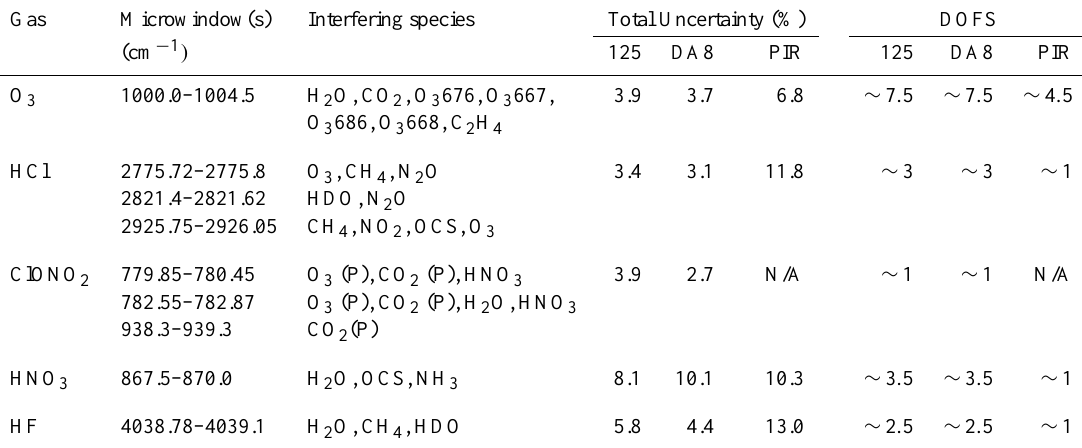
Table 1. Summary of retrieval microwindows and interfering species, with estimated total uncertainty and DOFS. Multiple microwindows are fitted simultaneously where more than one region is specified. Interfering trace gas species are scale fitted, unless profile fitting is indicated by a (P). Total uncertainty has been calculated, with individual uncertainties resulting from measurement, smoothing and model parameter errors added in quadrature, as described in Batchelor et al. (2009). The DOFS are representative values for spectra recorded at the beginning of March, when solar zenith angles of are typically > 80 ◦ . Abbreviations used in the headers are 125=125HR and PIR=PARIS-IR. Gas